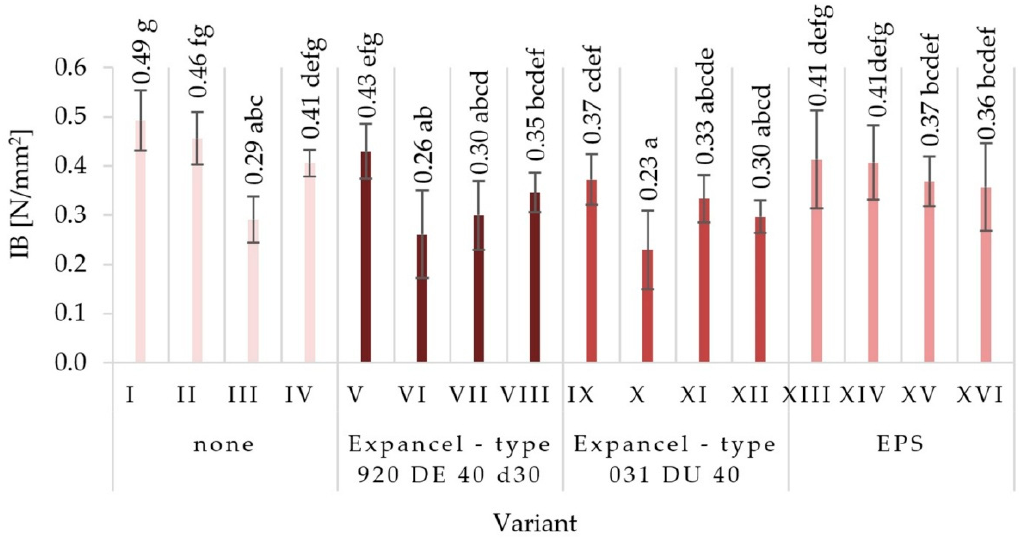
Figure 5. Internal bond strength (IB) of the particleboards produced (means and standard deviation, a, b, c, (…). Homogeneous groups were determined by the Tukey test; different letters denote a significant difference; means followed by the same letter do not statistically differ from each other).